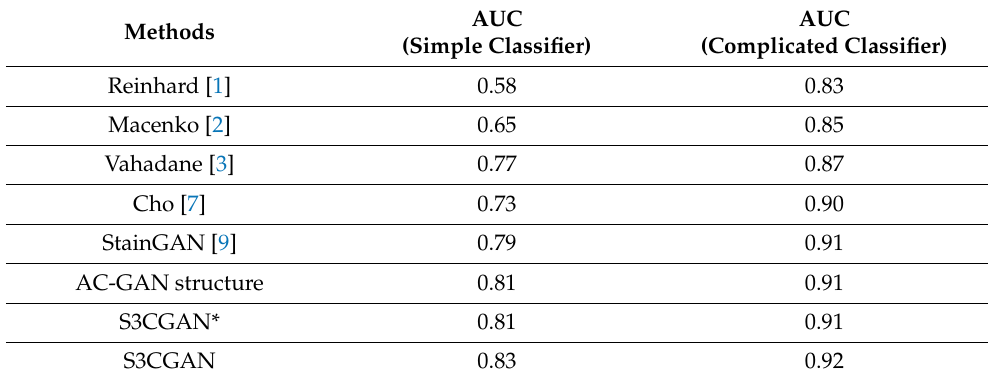
Figure 10. Transfer results obtained with different stain transfer methods. Table 1. AUC values obtained with each stain transfer method after the transfer outcome was input into the tumor classifier.